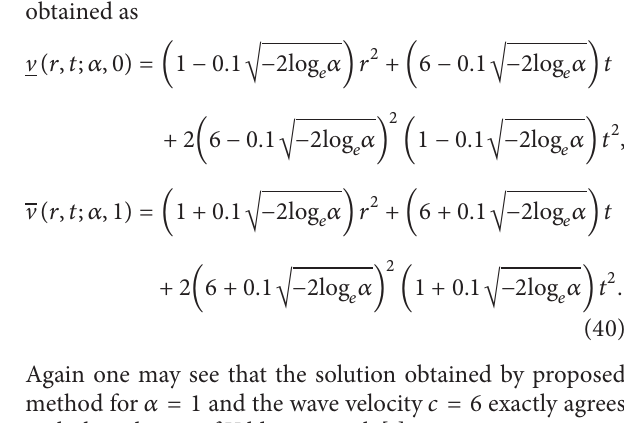
Figure 1: Fuzzy displacement at 𝑟 = 25 of Case 1.